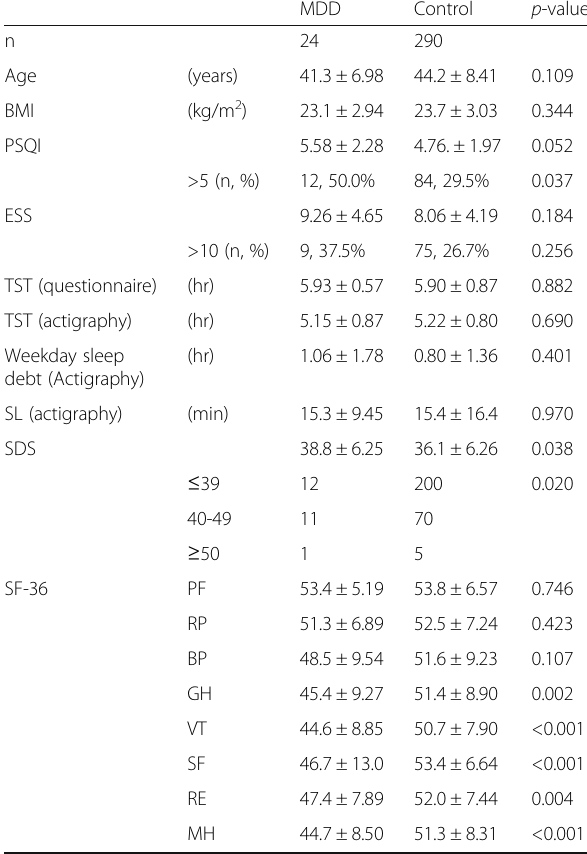
Table 3 Sleep, depression, and quality of life in participants with major depressive disorders (MDD) and controls MDD Control p